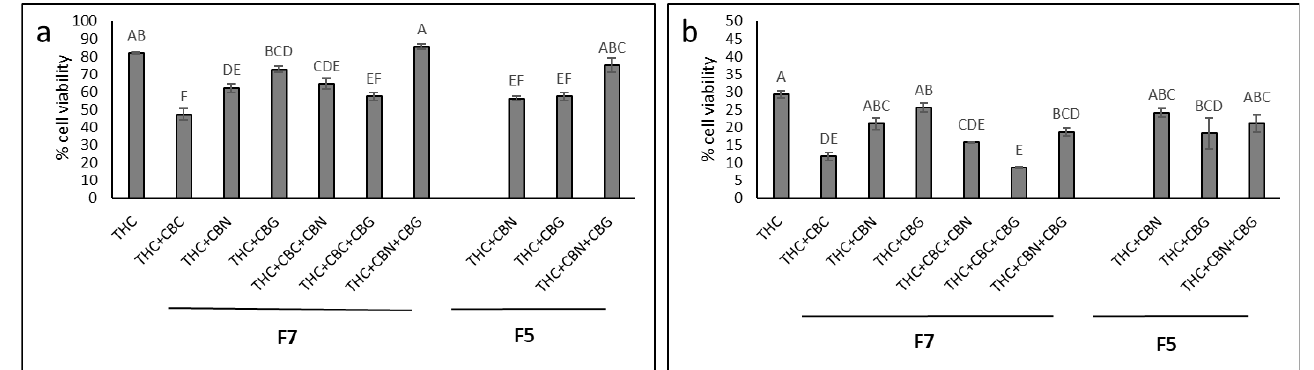
Figure 3. Cell viability of HTB75 ( a , b ) and HTB161 ( c , d ) cells following treatment with F5-SM and F7-SM at different concentrations for IC50 values at 48 h calculation from 5P logistic curve fit using GraphPad Prism version 6.1. Concentration 0 was the vehicle-treated control (2.50% and 3.50% v/v methanol for HTB75 and HTB161 respectively). Error bars indicate ± SE ( n = 3).